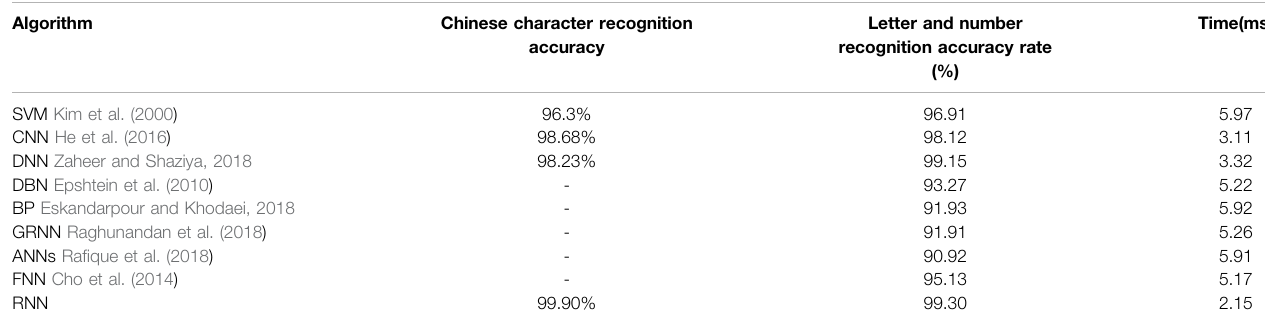
TABLE 1 | Comparison of experimental results.